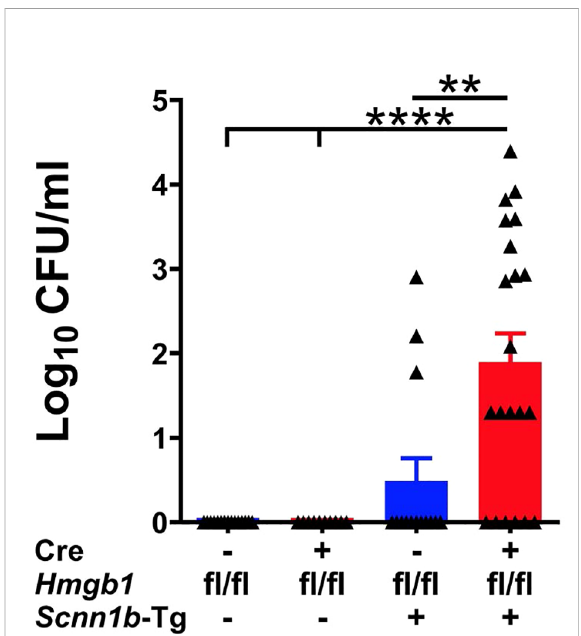
FIGURE 6 Airway epithelial cell-speci fi c deletion of HMGB1 compromises bacterial clearance of Tg+ mice. CFUs were counted in BALF from mice with different genotypes (Cre - /WT [blue open bar], Cre + /WT [red open bar], Cre - /Tg+ [solid blue bar], and Cre + /Tg+ [solid red bar] mice). The CFU values were log 10 -transformed. Error bars represent Mean ± SEM. One-way ANOVA followed by Tukey ’ s post hoc test was used for the statistical analysis. ** p < 0.01, **** p <